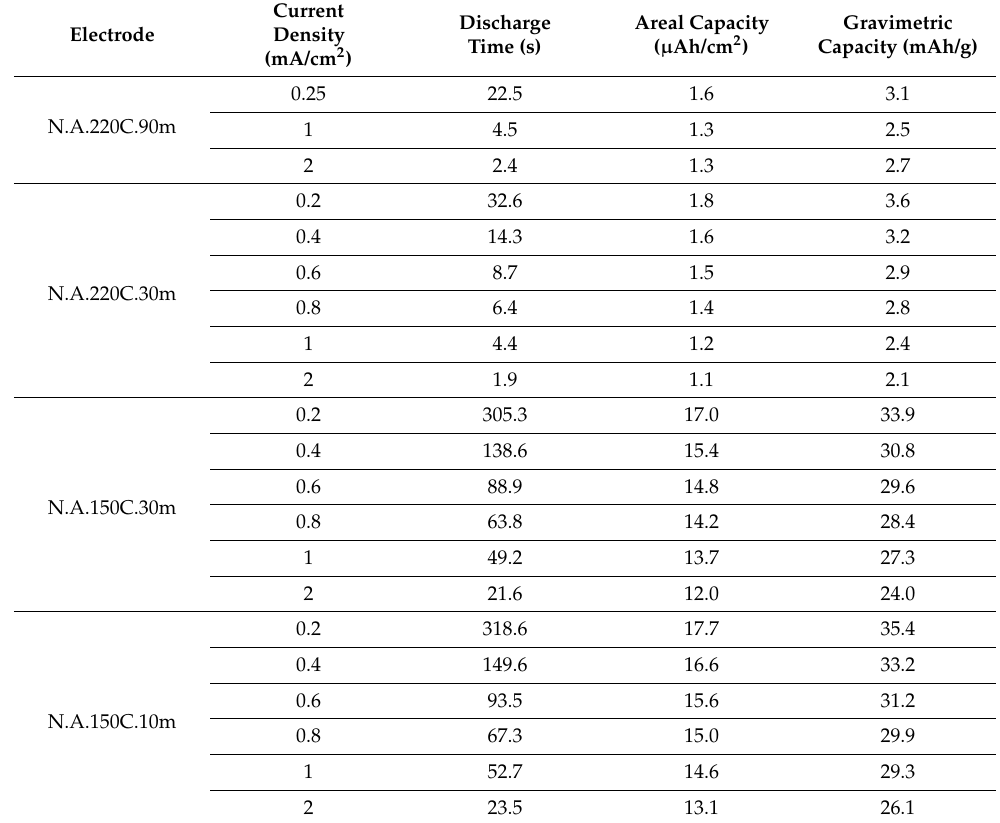
Table 3. Electrochemical properties of all electrodes on SS in KOH evaluated from GCD experiments, where the mass loading in each electrode is 0.5 mg/cm 2 .